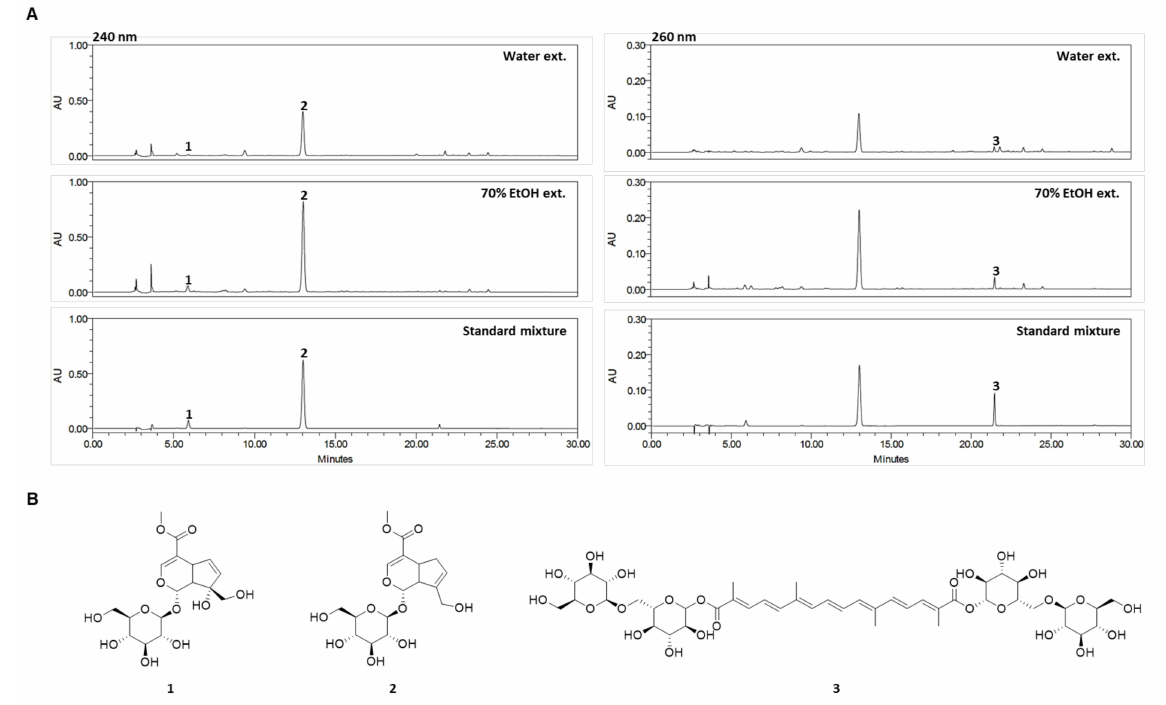
Figure 1. ( A ) High-performance liquid chromatography chromatograms of the water and 70% ethanol extracts of Gar- denia jasminoides and standard mixture at 240 and 260 nm. ( B ) Chemical structures of the three standard compounds. 1: gardenoside, 2: geniposide, and 3: crocin. Table 1. Regression equation, linearity, LOD, LOQ, and contents of the three compounds.